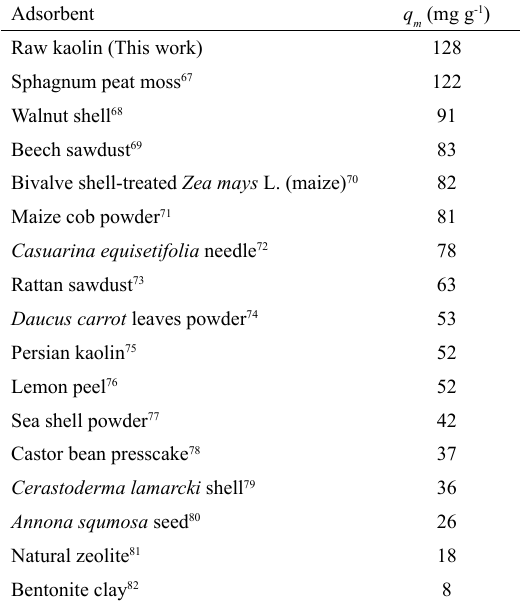
Table 2. Equilibrium parameters for the adsorption of MG onto natural kaolin. Equilibrium model